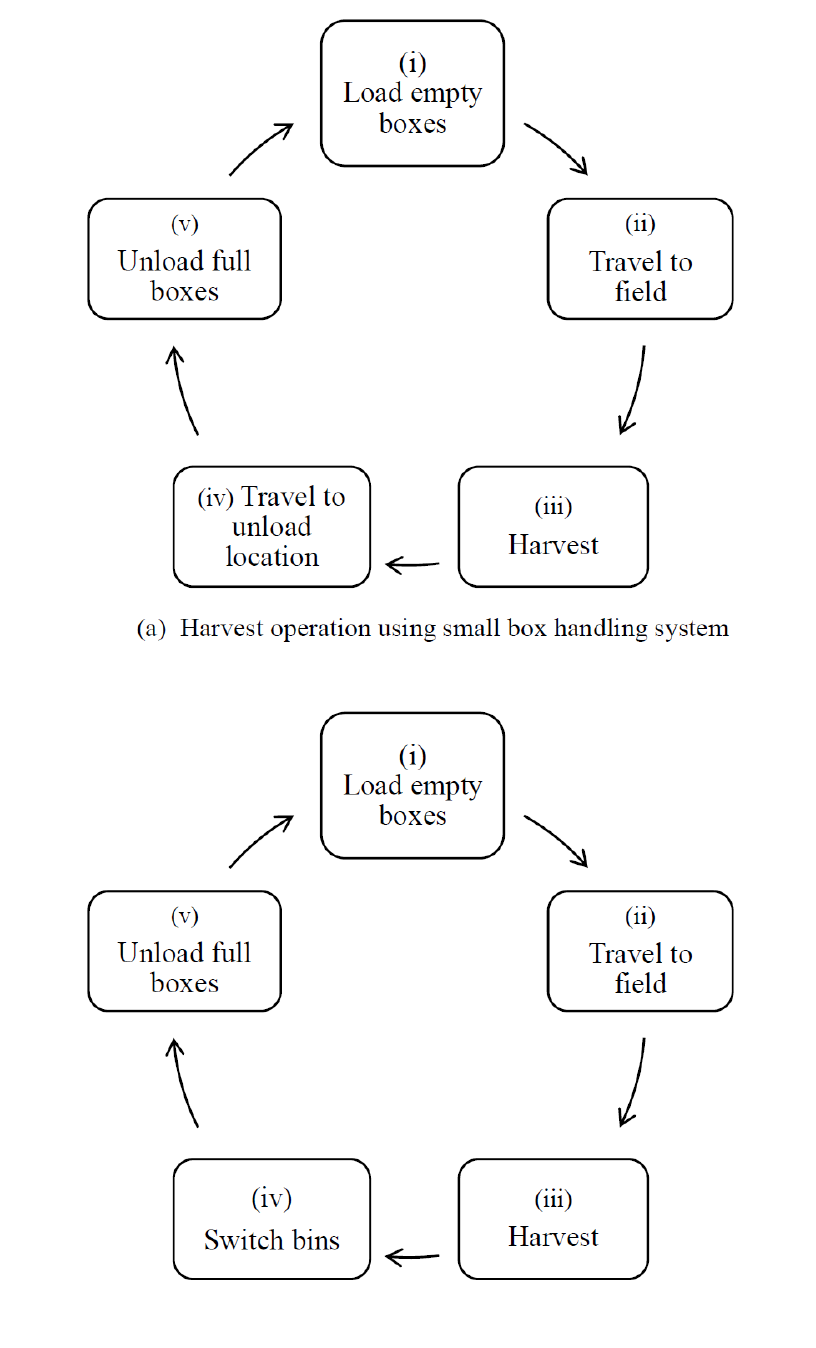
Figure 2. Process diagram for the small box handling system ( a ) and the large bin handling system ( b ).